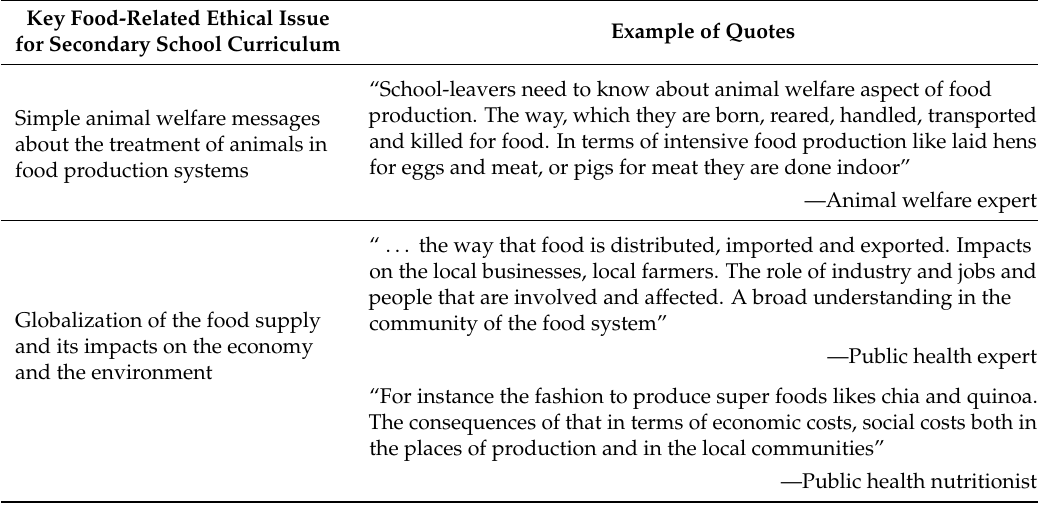
Table 1. Summary of the ethical issues raised by the